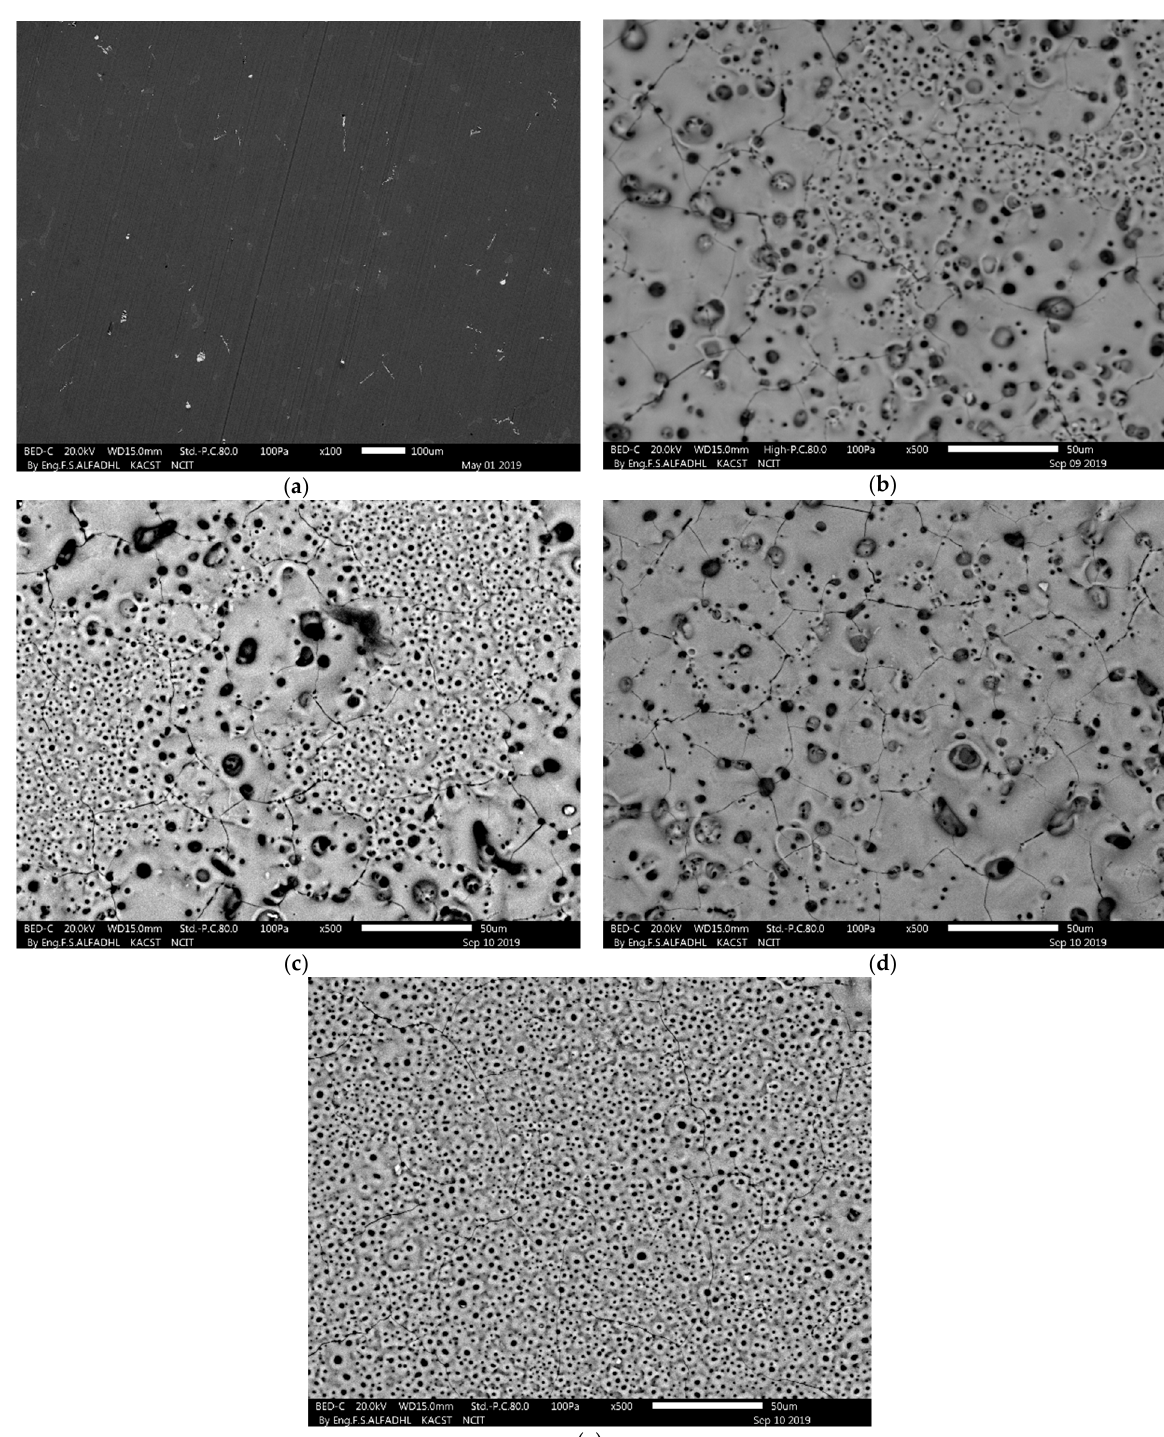
Figure 2. SEM micrographs of AM60 alloy subjected to PEO coating at different conditions: ( a ) BM, ( b ) UP, ( c ) BP30, ( d ) BP50 and ( e ) BP66.